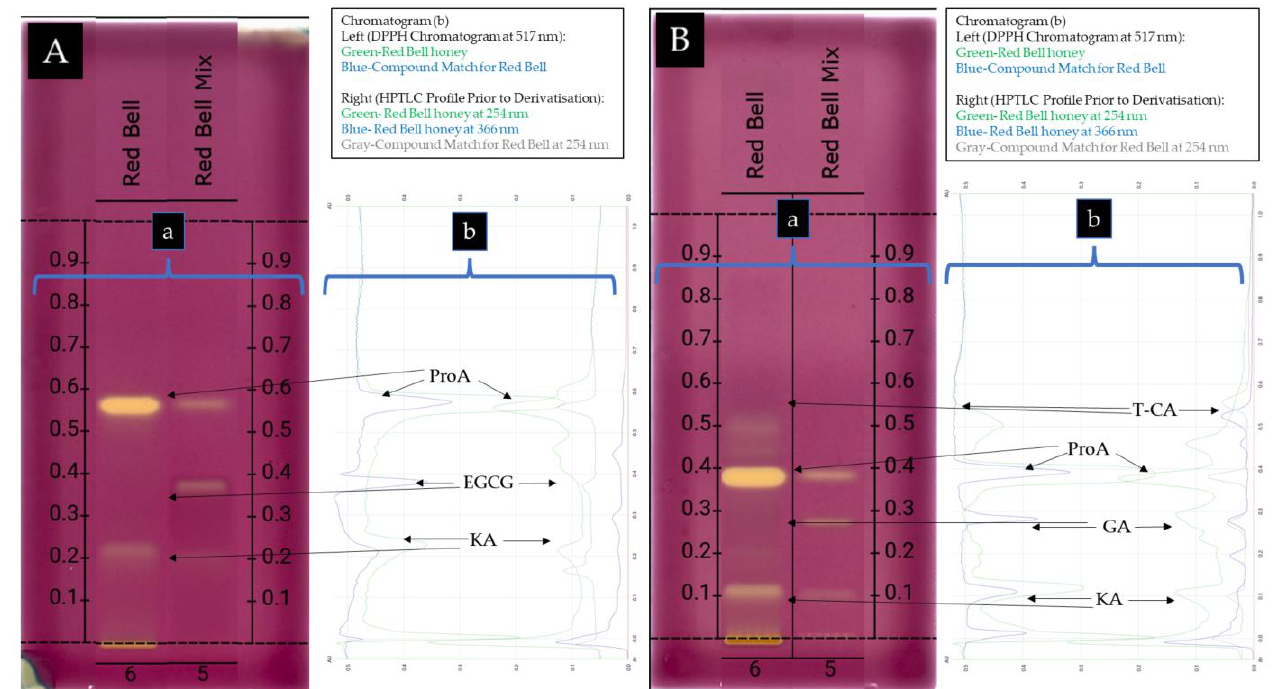
Figure 9. HPTLC-DPPH plate image (a) of Calothamnus spp. (Red Bell) honey after development in MPA ( A ) and after development in MPB ( B ) recorded with transmission white light, and comparison of the peak profiles of Calothamnus spp. (Red Bell) honey (green) and Red Bell honey spiked with the identified compounds (blue) after derivatisation with DPPH reagent and scanning at 517 nm (b-left) and comparison of the profiles of Calothamnus spp. (Red Bell) honey obtained at 254 nm (green) and 366 nm (blue) prior to derivatisation and the profile of Calothamnus spp. (Red Bell) honey spiked with the identified compounds (gray) obtained at 254 nm prior to derivatisation (b-right) .